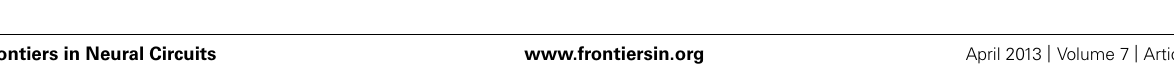
Frontiers in Neural